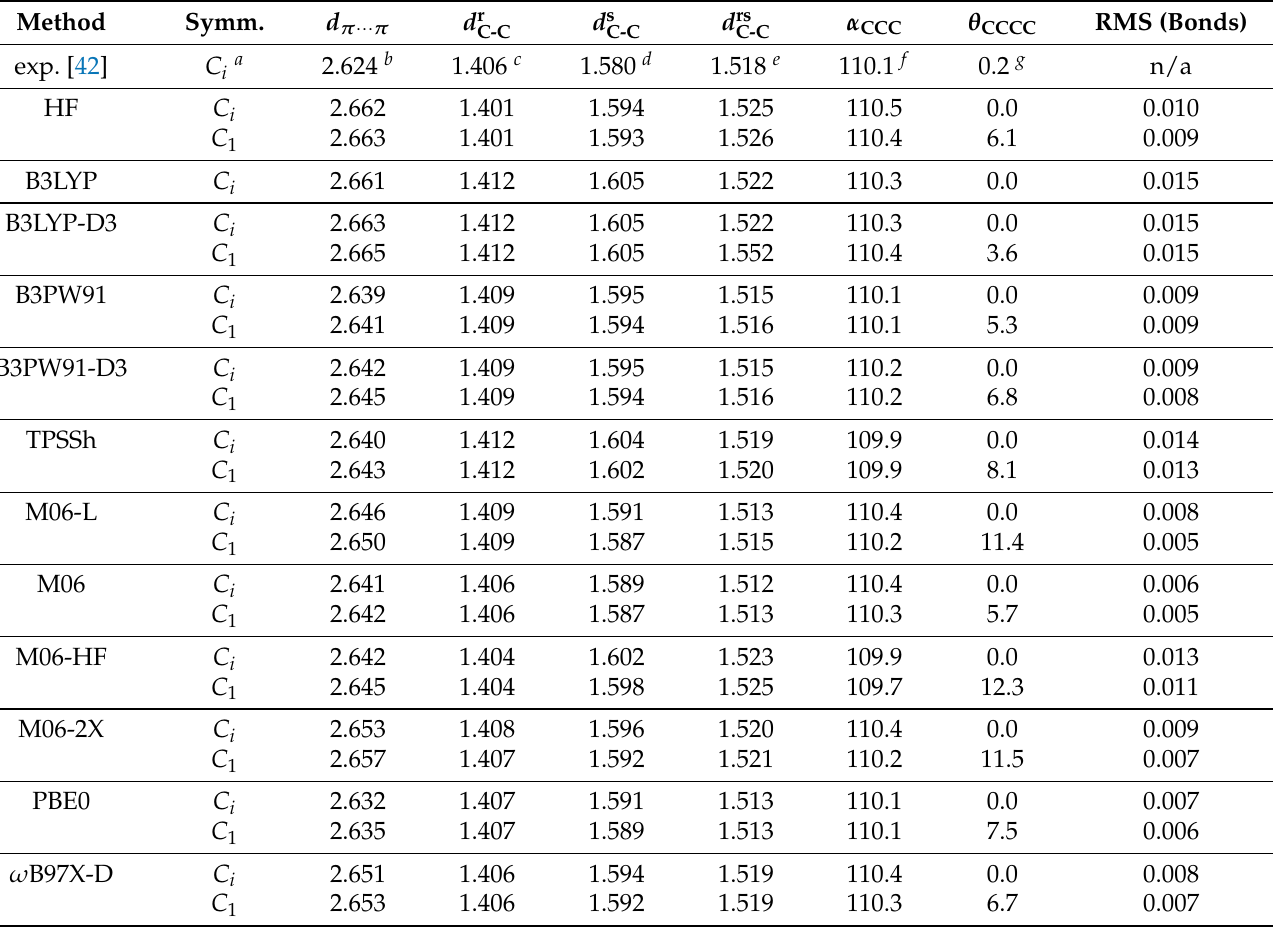
Table 1. The mean values (in Å or degrees) of the most important geometric parameters (see Figure 1) and the RMS for the bonds calculated for the superphane molecule in the C i and C 1